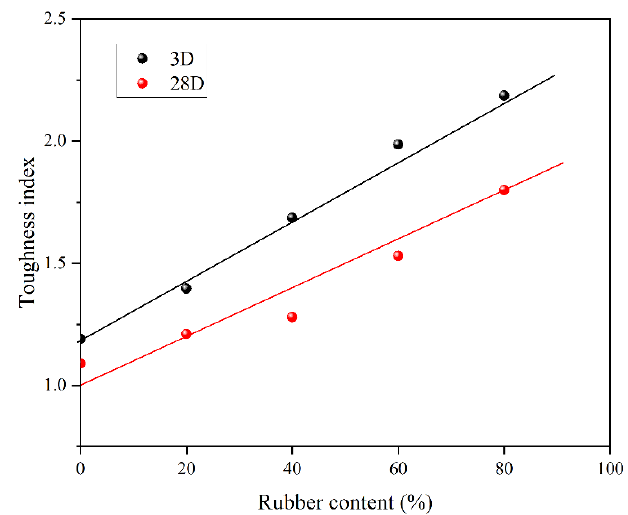
Figure 7. Calculating the toughness index.